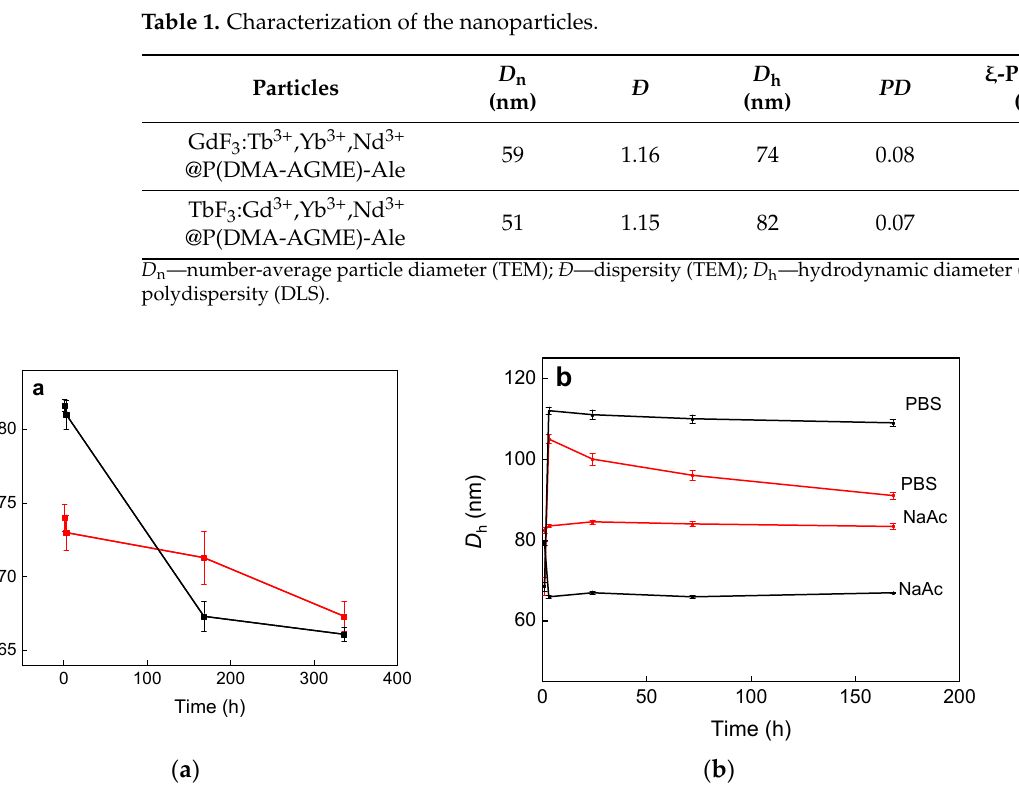
Figure 2. Dependence of hydrodynamic diameter D h of P(DMA-AGME)-Ale-coated GdF 3 :Tb 3+ ,Yb 3+ ,Nd 3+ (red) and TbF 3 :Gd 3+ ,Yb 3+ ,Nd 3+ nanoparticles (black) in ( a ) water and ( b ) PBS and NaAc buffers. The particles were prepared at reaction temperature 75 °C.